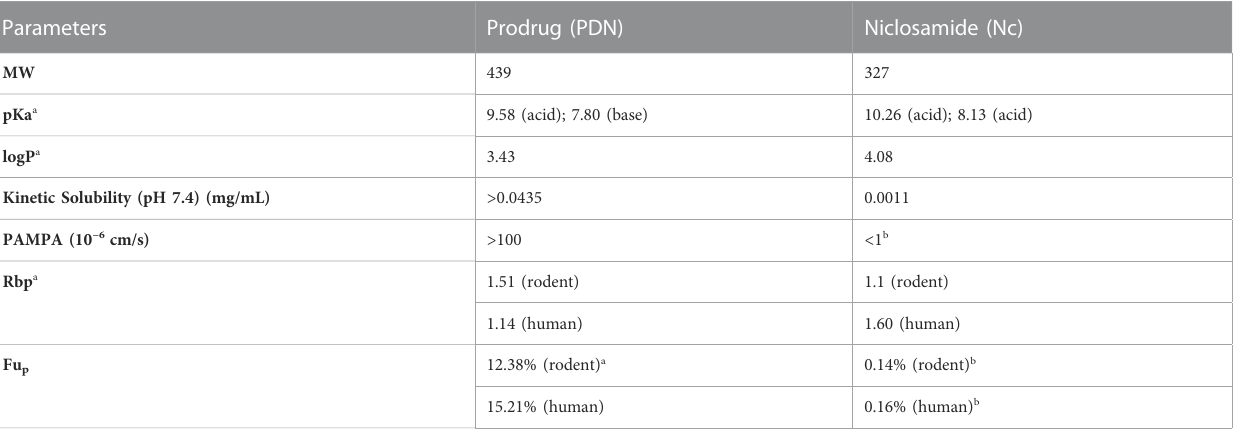
TABLE 2 Physiochemical properties of PDN and Nc.